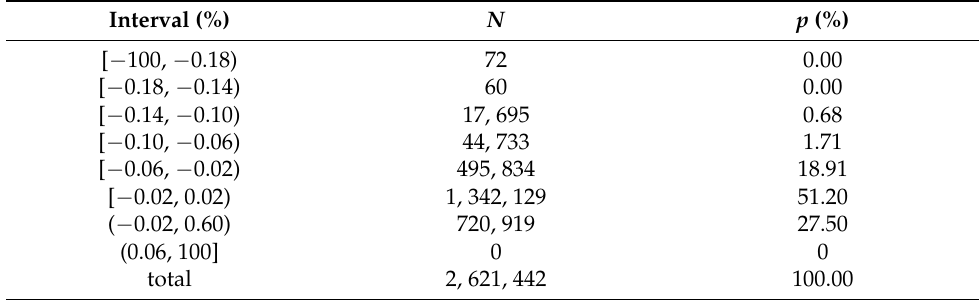
Table 4. The number of grids in refined D area interval of OURS grid.